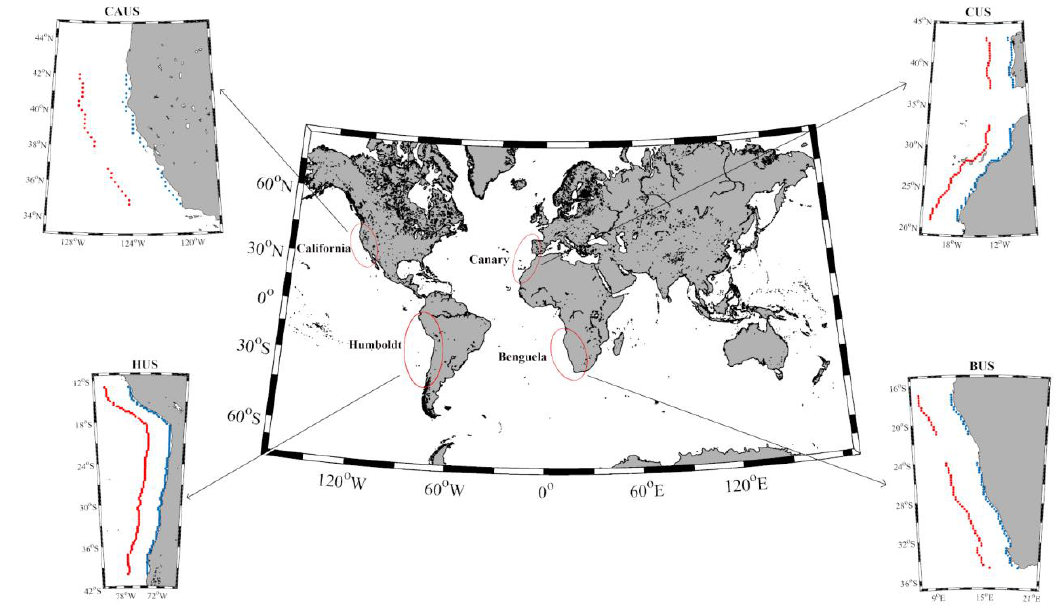
Figure 1. Eastern upwelling systems (EBUS). Blue (red) circles identify the coastal (oceanic) points selected. BUS: Benguela Upwelling System, CUS: Canary Upwelling System, HUS: Humboldt Upwelling System, and CAUS: California Upwelling System.